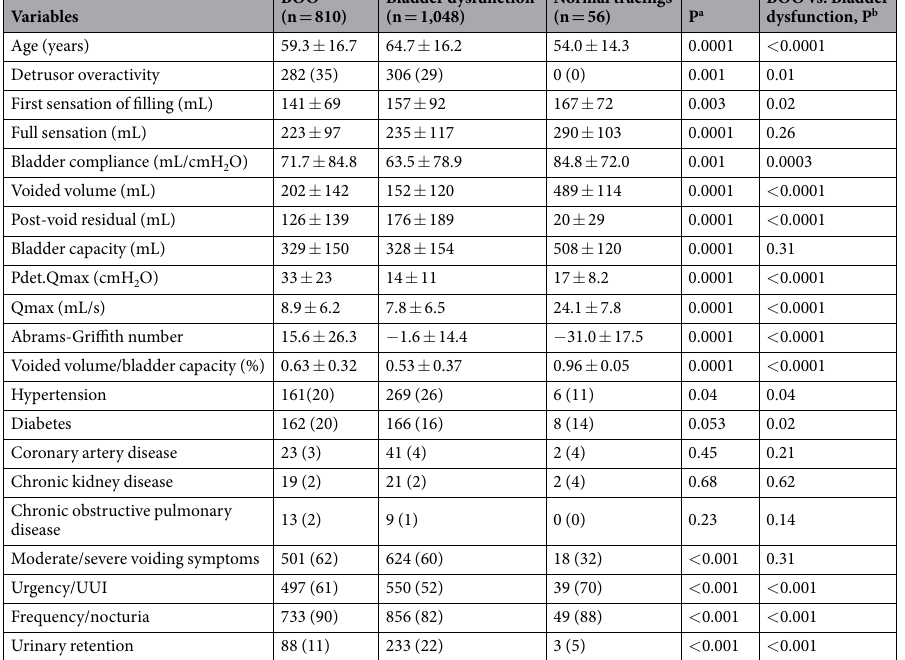
Table 1. Comparisons of videourodynamic diagnoses in women with voiding dysfunction symptoms (n = 1,914). Data were expressed as the mean ± standard deviation or number (percentage). BOO = bladder outlet obstruction; Pdet.Qmax = voiding detrusor pressure at Qmax; Qmax = maximum flow rate; and UUI = urgency urinary incontinence. a By Kruskal-Wallis test or chi-square test. b By Wilcoxon rank-sum test or chi-square